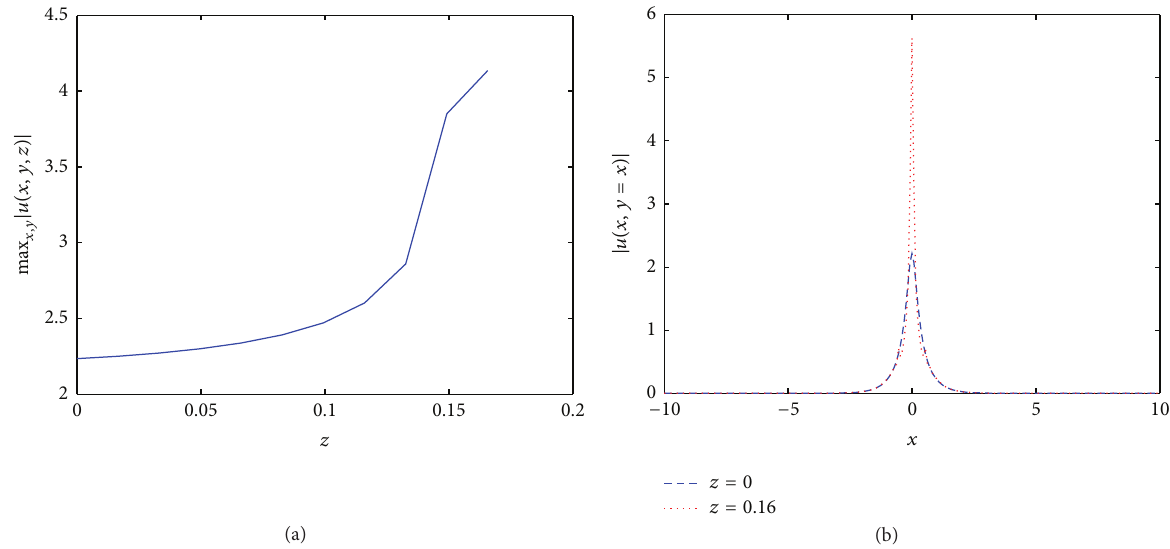
Figure 21: Nonlinear evolution of the lattice soliton without the optical lattice with 𝜇 = 1.5 for the self-focusing quintic model. (a) Peak amplitude of the lattice soliton as a function of the propagation distance. The initial condition is taken as the lattice soliton with a 0.01 noise in the amplitude and phase; (b) cross section along the diagonal axis of the lattice soliton before and after evolutions ( 𝑧 = 0 and 𝑧 = 0.16 ).